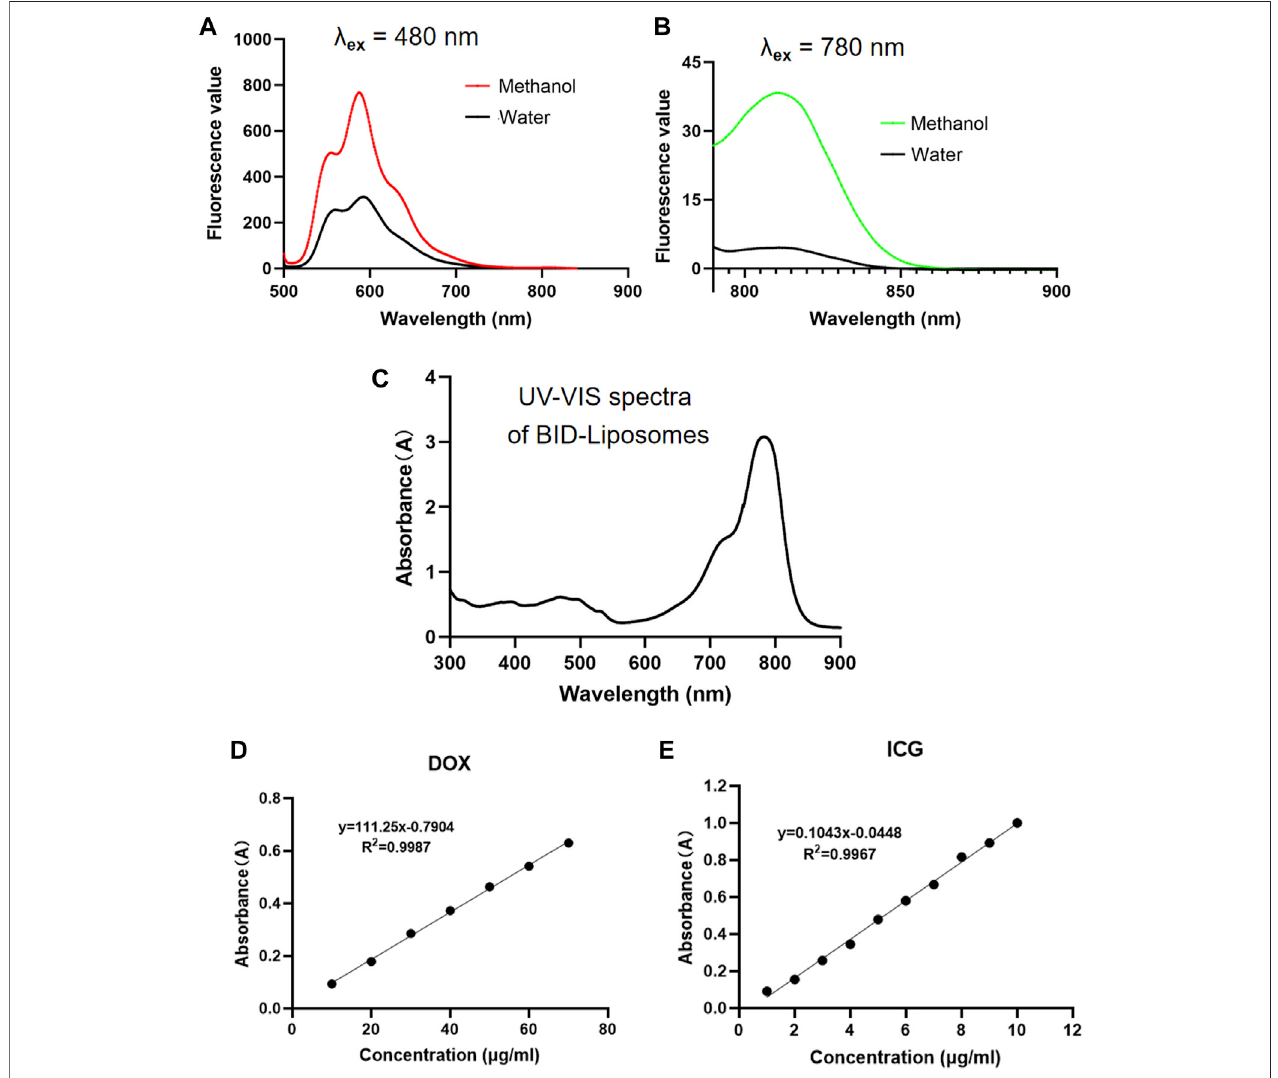
FIGURE 4 | In vitro fl uorescence and UV – vis spectrum assay of BID-liposomal nanocomposites. (A) The emission spectra (500 – 900 nm) of BID-liposomes diluted with 30-fold methanol or water under the excitation wavelength of 480 nm. (B) The emission spectra (790 – 900 nm) of BID-liposomes diluted with 30-fold methanol or water under the excitation wavelength of 780 nm. (C) The UV – vis spectrum (300 – 900 nm) of BID liposomes. (D) Standard curve of DOX by the absorbance assay. (E) Standard curve of ICG by the absorbance